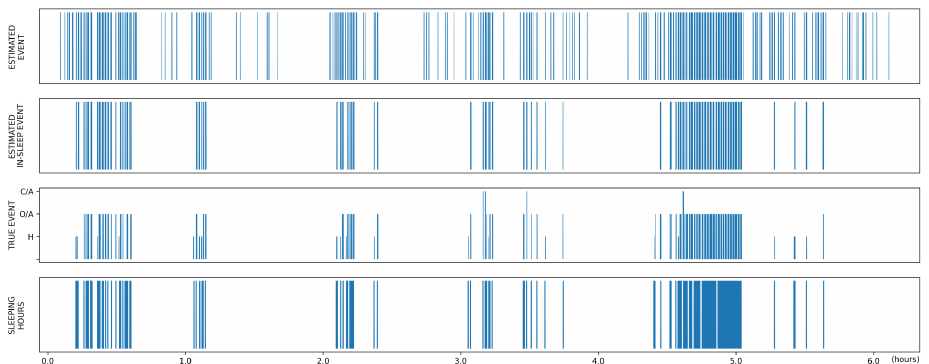
Figure 10. Prediction result of a whole PSG recording from an example case with poor sleep efficiency. The first row shows the estimated abnormal respiratory events. When considering sleep status (last row), false-positive detections at waking hours are reduced (second row), resulting in predictions more similar to the ground truth (third row). H = hypopnea, O/A = obstructive apnea, C/A = central